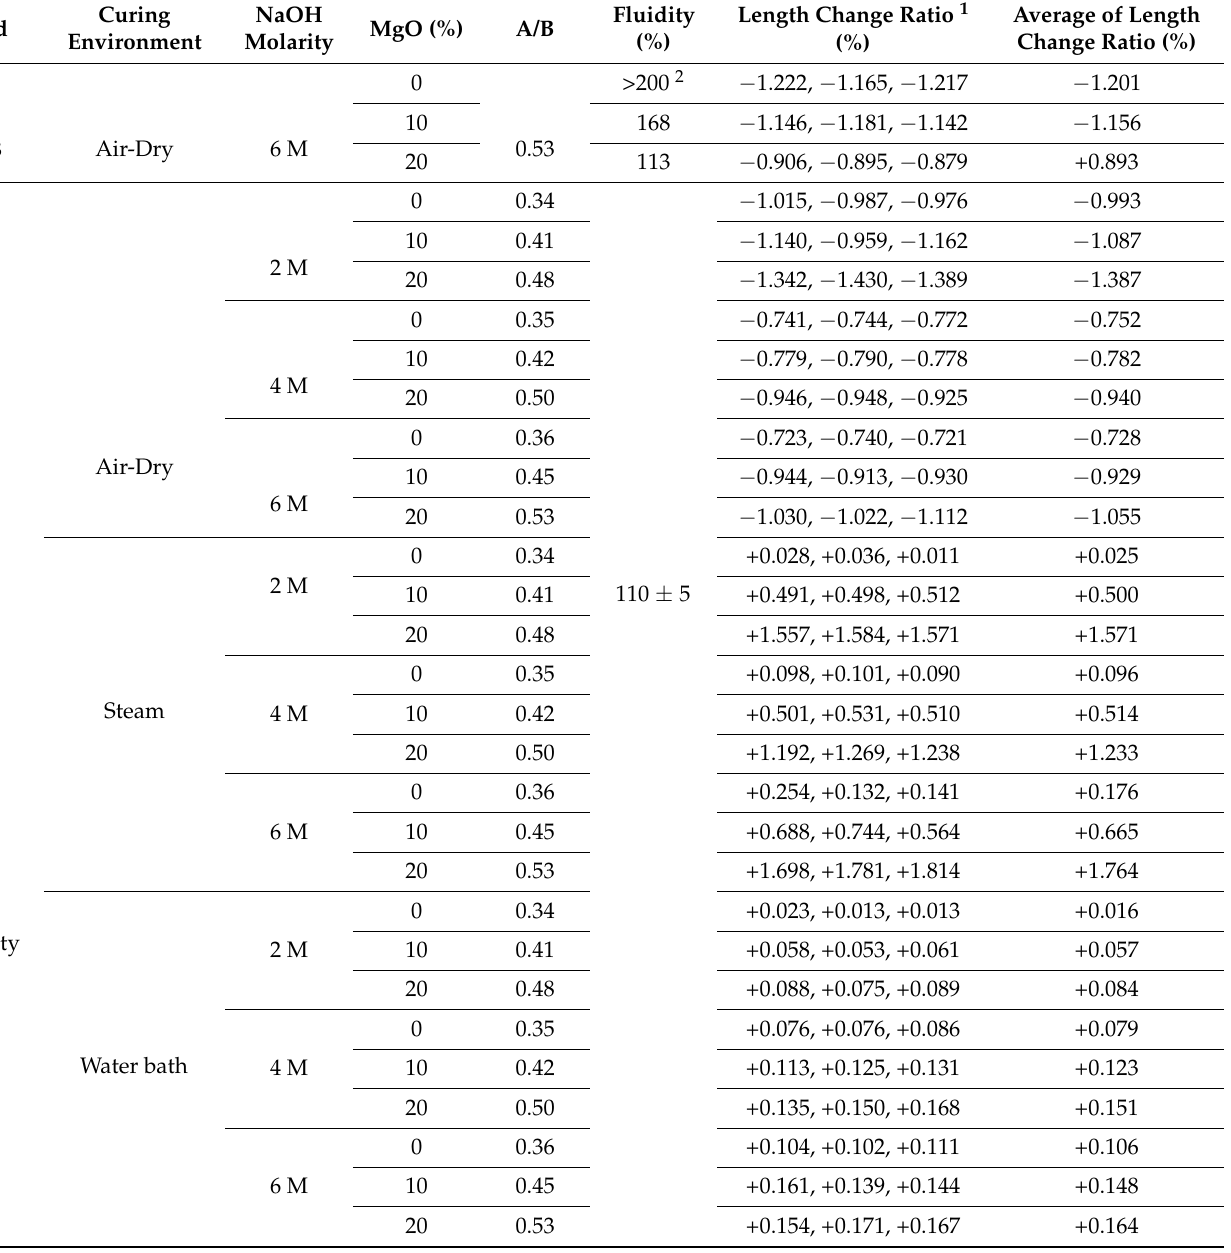
Table 5. The length change ratios of the specimens unmolded at the age of 24